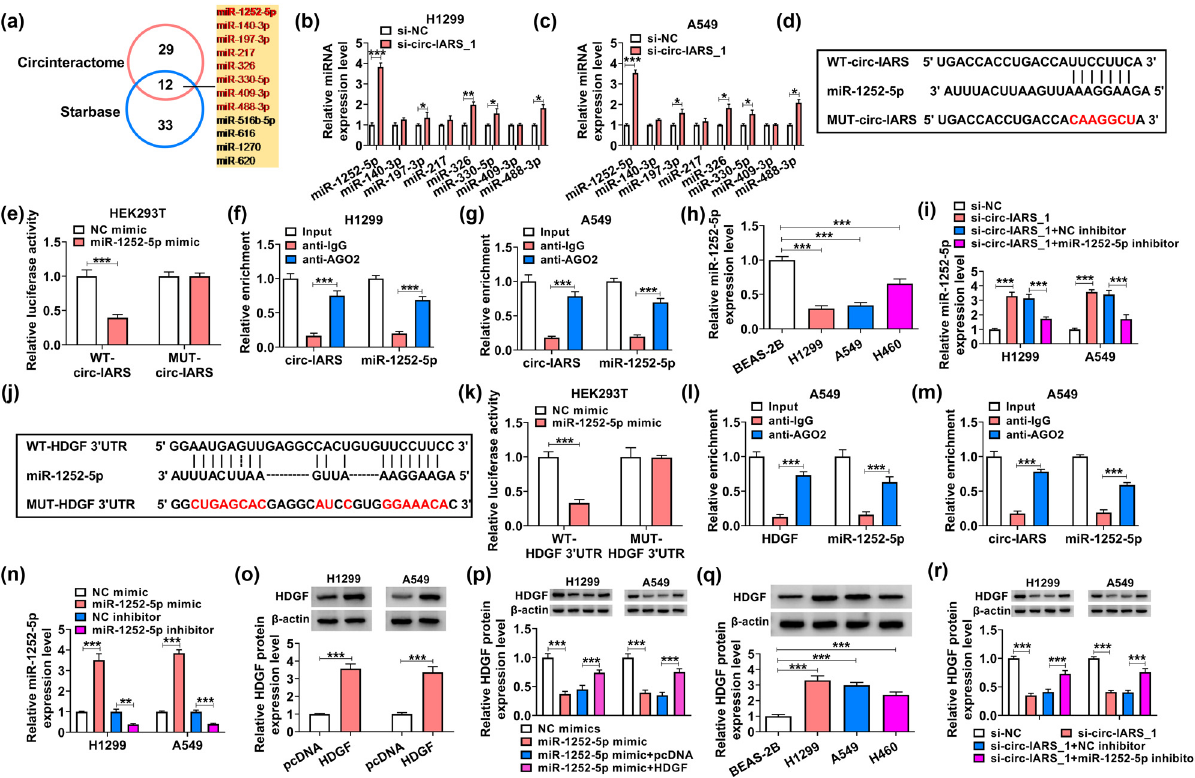
Figure 3: Circ - IARS served as a ceRNA for miR - 1252 - 5p to regulate HDGF in NSCLC cells. ( a ) Circinteractome website and StarBase website together presented 12 miRNAs that were complementary to circ - IARS. ( b and c ) RT - qPCR detected the relative expression levels of 8 miRNAs in H1299 and A549 cells transfected with si - circ - IARS_1 or si - NC. ( d ) Schematic diagram showing the predicted binding sites between WT - circ - IARS and miR - 1252 - 5p sequences. ( e ) Dual - luciferase reporter assay measured the relative luciferase activity of WT - circ - IARS reporter vector and MUT - circ - IARS reporter vector in HEK293T cells transfected with miR - 1252 - 5p mimic or NC mimic. ( f and g ) RIP assay evaluated the relative enrichment of circ - IARS and miR - 1252 - 5p by AGO2 or IgG in H1299 and A549 cells, normalized to the input of cells. ( h and i ) RT - qPCR measured the relative miR - 1252 - 5p expression level in ( h ) BEAS - 2B, H1299, A549, and H460 cells, and ( i ) H1299 and A549 cells transfected with si - NC, si - circ - IARS_1, si - circ - IARS_1 + miR - 1252 - 5p inhibitor, or si - circ - IARS_1 + NC inhibitor. ( j ) Schematic diagram showing the predicted binding sites between WT - HDGF 3 ′ UTR and miR - 1252 - 5p sequences. ( k ) Dual - luciferase reporter assay measured the relative luciferase activity of WT - HDGF 3 ′ UTR reporter vector and MUT - HDGF 3 ′ UTR reporter vector in HEK293T cells transfected with miR - 1252 - 5p mimic or NC mimic. ( l and m ) RIP assay evaluated the relative enrichment of HDGF and miR - 1252 - 5p by AGO2 or IgG in H1299 and A549 cells, normalized to the input of cells. ( n ) RT - qPCR measured the relative miR - 1252 - 5p expression level in H1299 and A549 cells transfected with miR - 1252 - 5p mimic, miR - 1252 - 5p inhibitor, NC mimic, or NC inhibitor. ( o – r ) Western blotting detected the relative HDGF protein expression in ( o and p ) H1299 and A549 cells transfected with HDGF vector, pcDNA vector, miR - 1252 - 5p mimic, NC mimic, miR - 1252 - 5p mimic + HDGF vector, or miR - 1252 - 5p mimic + pcDNA vector, and ( q ) BEAS - 2B, H1299, A549, and H460 cells, as well as ( r ) H1299 and A549 cells transfected with si - NC, si - circ - IARS_1, si - circ - IARS_1 + miR - 1252 - 5p inhibitor, or si - circ - IARS_1 + NC inhibitor. * P < 0.05, ** P < 0.01, and *** P <